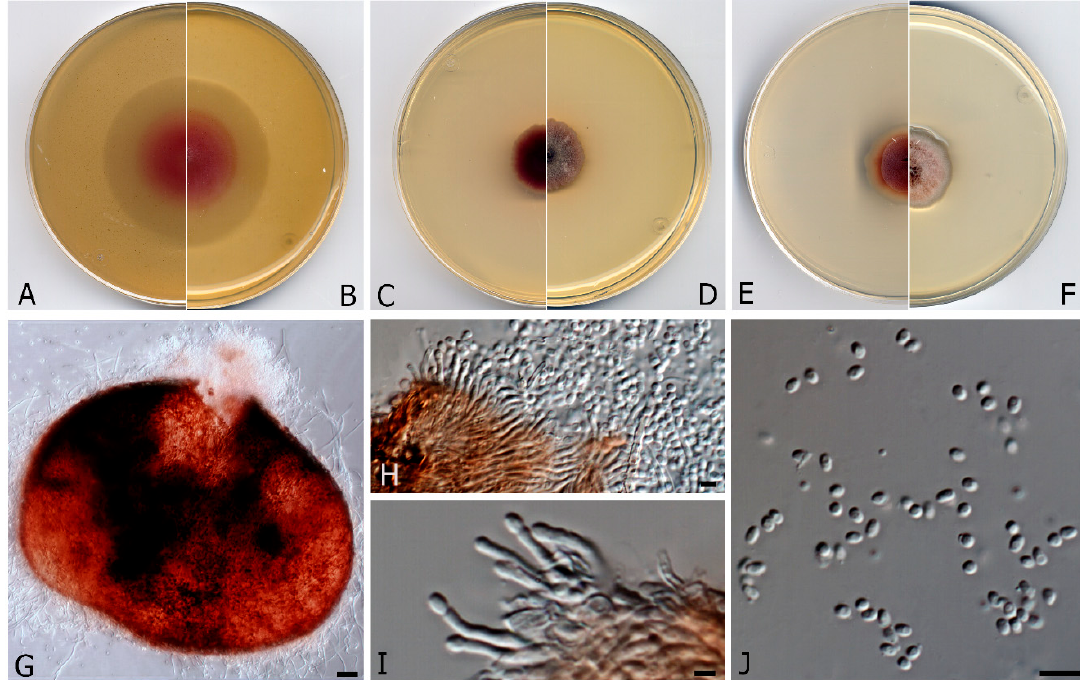
Figure 4. Murispora asexualis CBS H-24463. ( A , B ) Colonies on OA (reverse and front), ( C , D ) MEA 2% (reverse and front), ( E , F ) PDA (reverse and front). All media at 15 °C after 3 weeks. ( G ) Pycnidia ( H , I ) Conidiogenous cells ( J ) Conidia. Scale bars: ( G ) = 25 µm, ( H , J ) 10 µm, ( I ) = 2.5 µm. Etymology . Because of the lack of a sexual morph, typical of the genus.